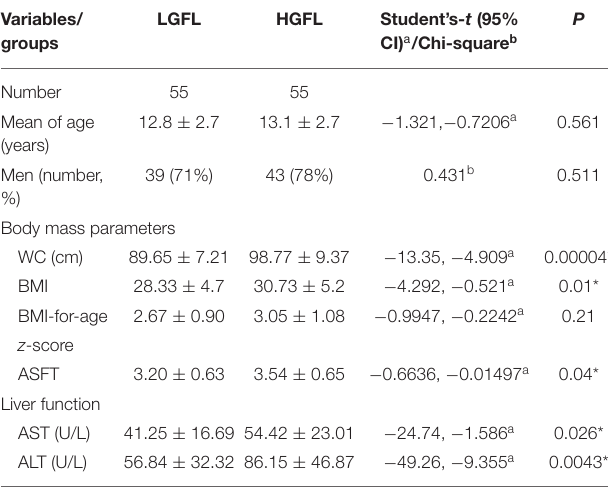
TABLE 2 | Differences of clinical characteristics between the LGFL and HGFL